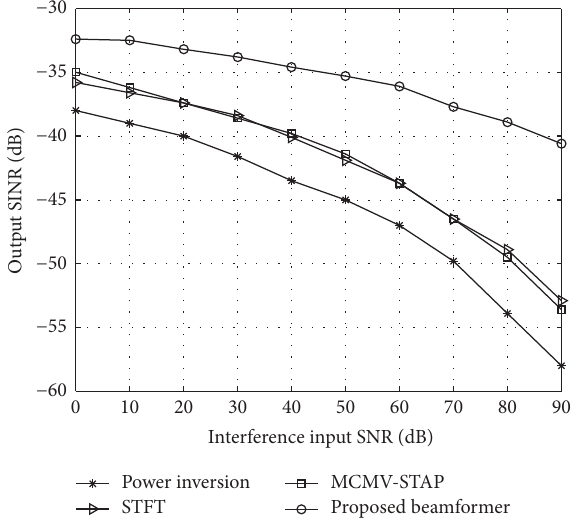
Figure 10: The output SINR of different method when suppress jamming: the angle of arrival of the satellite signal is 0 degrees and the angles of arrival of jamming signals are − 6 degrees, 12 degrees, and 40